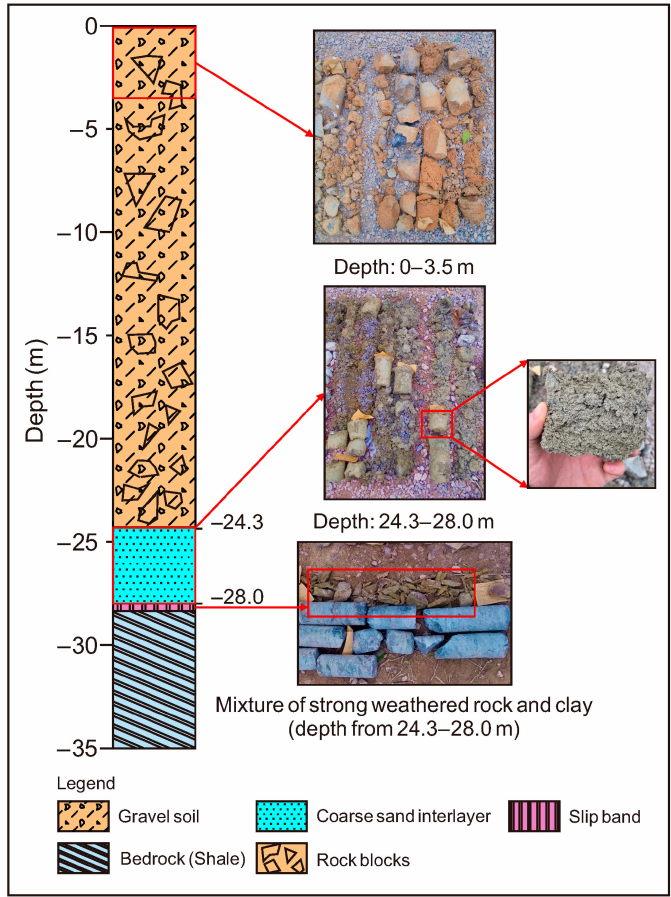
Figure 6. Lithology of the borehole